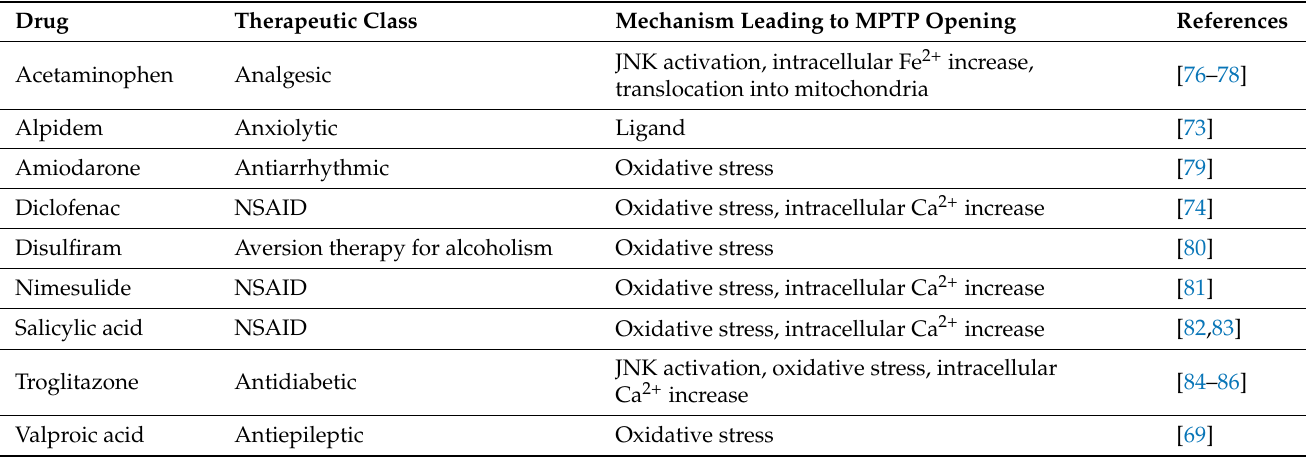
Figure 3. Schematic representation of the main mechanisms and consequences of drug-induced mitochondrial dysfunction. Created with Biorender.com (accessed on 21 February 2022; Toronto, ON, Canada). (MPTP— mitochondrial permeability transition pore; OXPHOS—oxidative phosphorylation; ATP— adenosine triphosphate; ROS—reactive oxygen species; mtDNA—mitochondrial DNA). Table 1. DILI drugs reported to induce MPTP opening. (DILI—drug-induced liver injury; MPTP— mitochondrial permeability transition pore; JNK—c-Jun N terminal protein kinase; NSAID— nonsteroidal anti-inflammatory